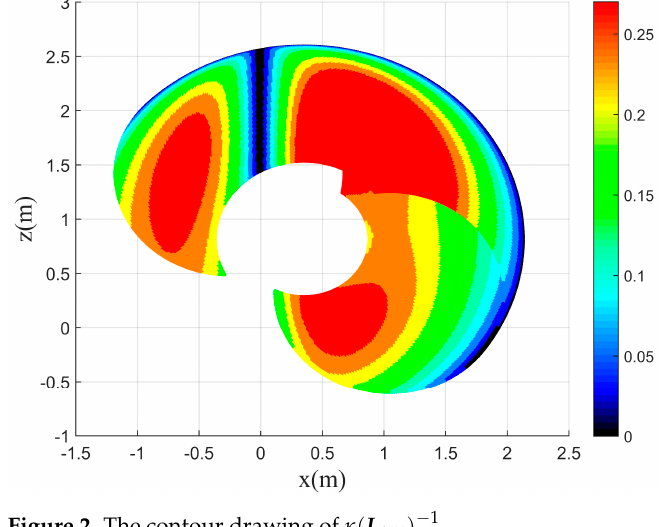
d are the minimum 1